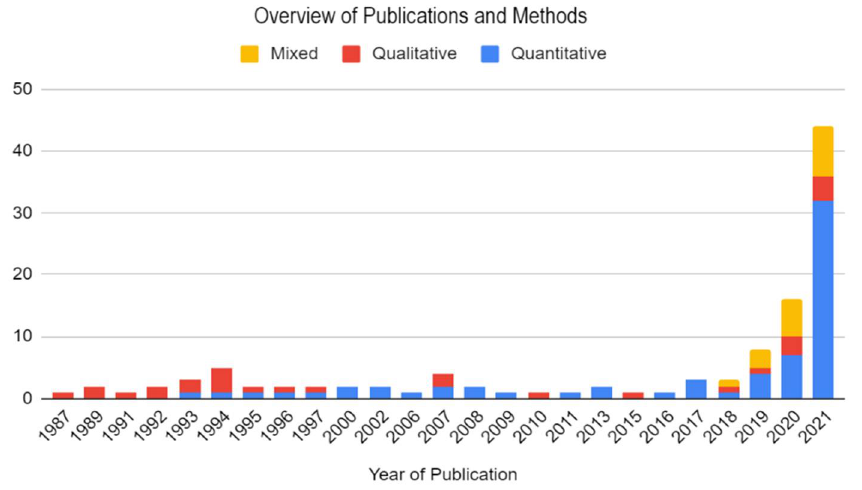
Figure 2. Overview of Publications and Methods .